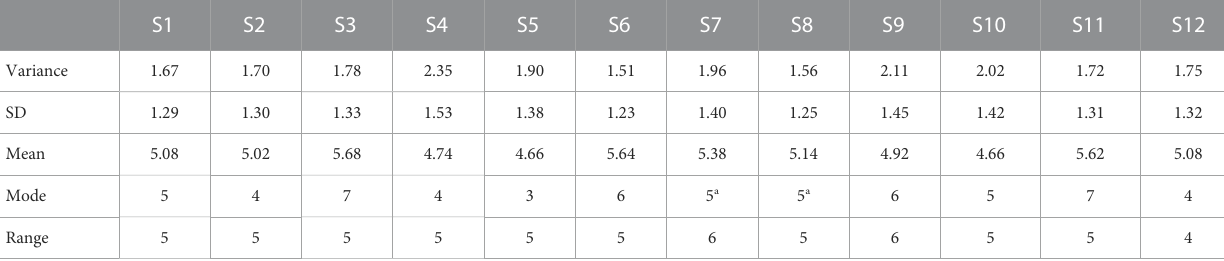
TABLE 4 Descriptive statistics of the